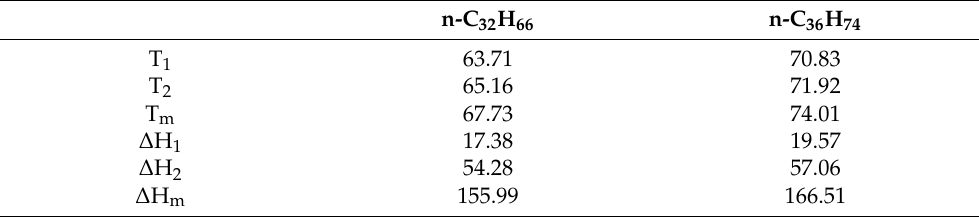
Table 1. Data Obtained from Resulting DSC Thermal Curves for n-Paraffins of this